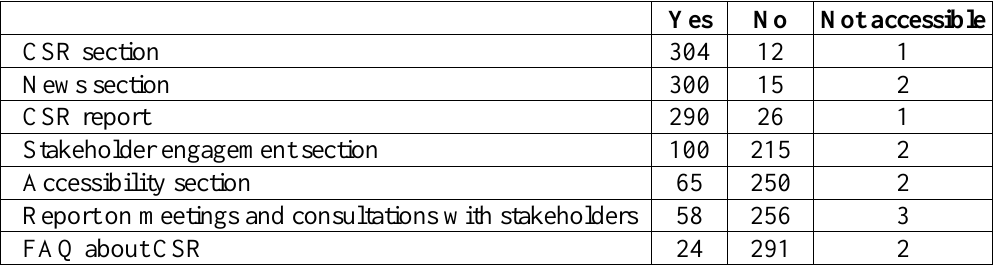
Table 3: Instrumental Published Communication Tools Used by DJSI Listed